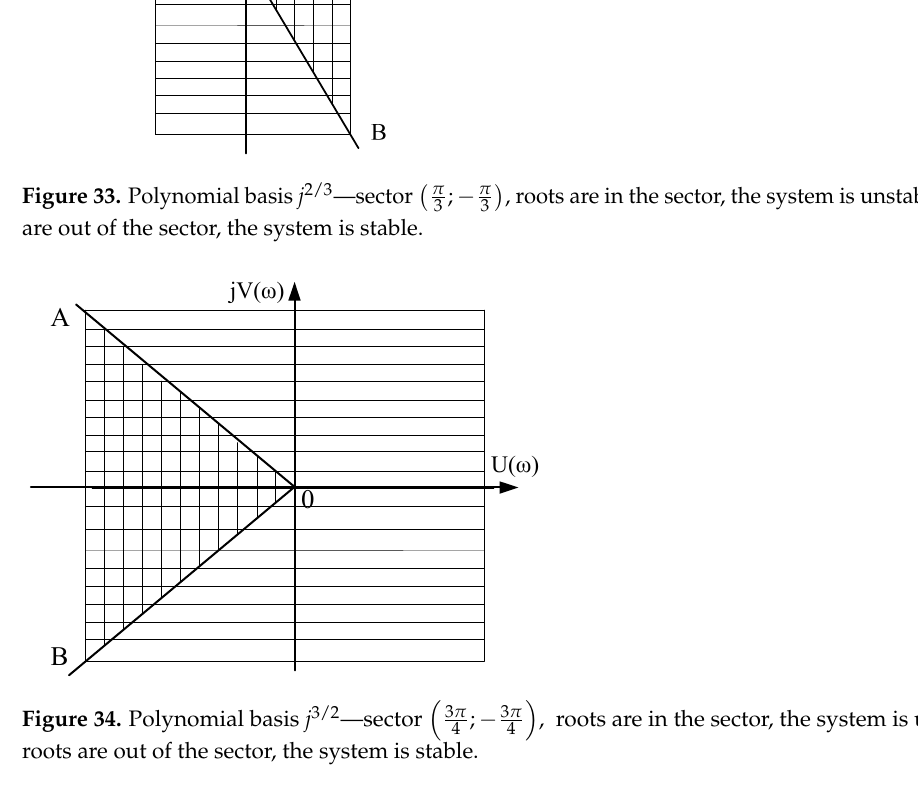
(cid:16) (cid:17) 3 π ; − 3 π , roots are in the sector, the system is unstable; (cid:4673), roots are in the sector, the system is unstable; ; − 𝟑𝝅 4 4 𝟒 𝟒 (cid:4673), roots are in the sector, the system is unstable; ; − 𝟑𝝅 𝟒 𝟒 (cid:4673), roots are in the sector, the system is unstable; ; − 𝟑𝝅 𝟒 𝟒